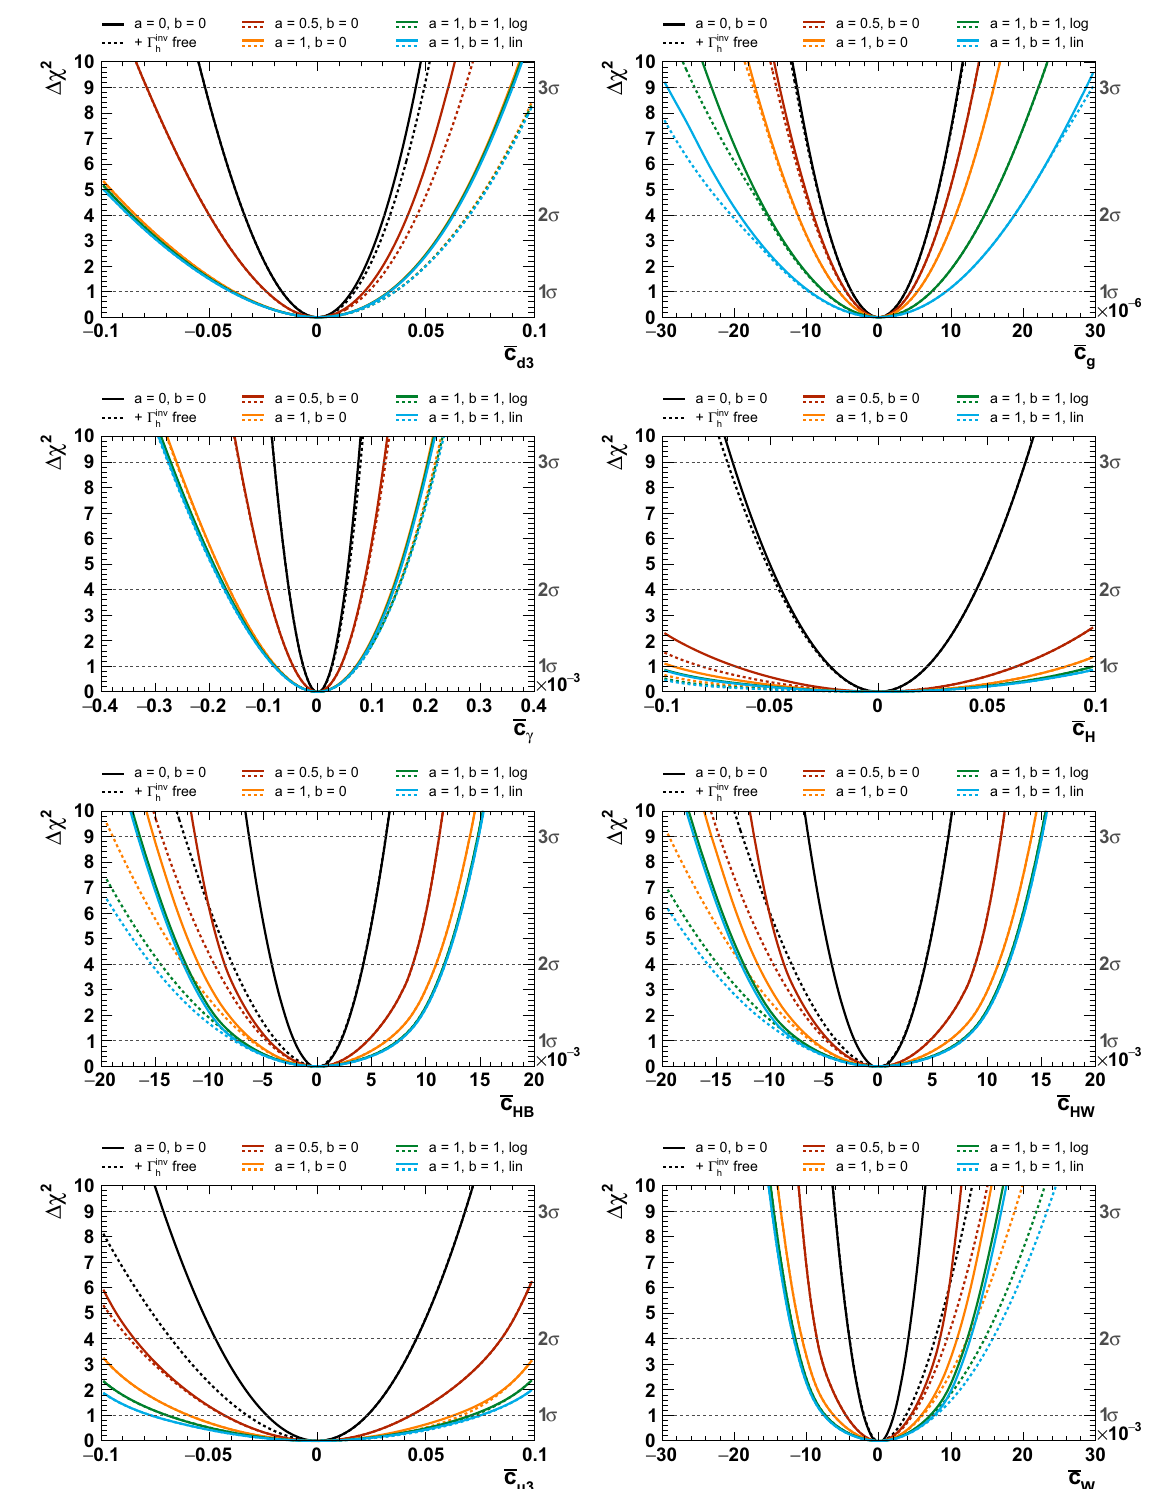
Fig. 1 Scans of the sum of squared residuals (cid:12)χ 2 as a function of the Wilson coefficients ¯ c d , 3 , ¯ c g , ¯ c γ , ¯ c H , ¯ c HB , ¯ c HW , ¯ c u , 3 , and ¯ c W (from top left to bottom right), obtained by using differential Higgs p T dis- tributions. Different assumptions on theoretical uncertainties as given